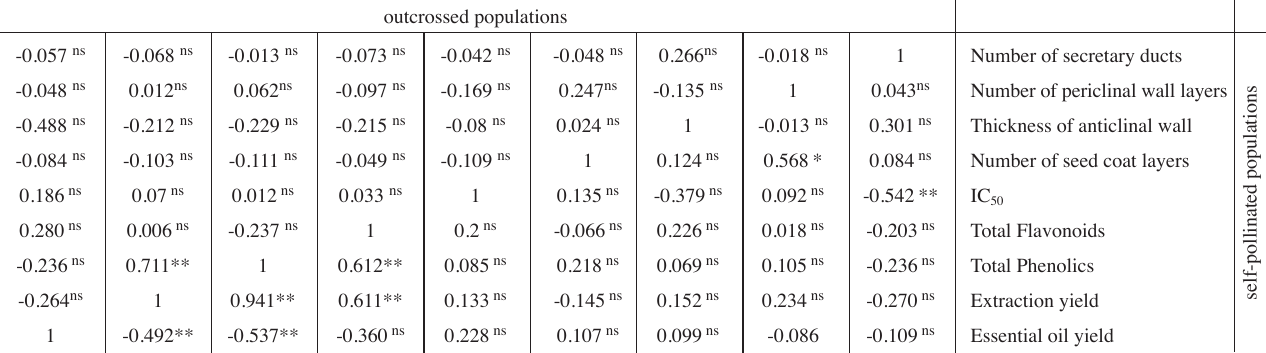
Tab. 4: Correlation of some anatomical characters and secondary metabolites in outcross and self-pollinated populations of fennel used in this study outcrossed